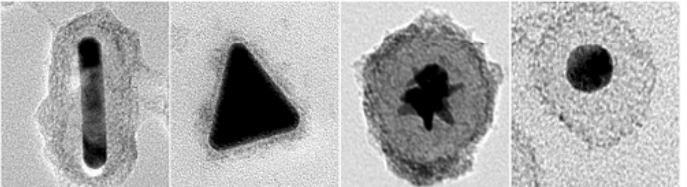
Figure 16. Some non-spherical AFNSs built using a PPy adhesion layer. Reproduced with permission from [86]. Springer Nature, 2016.